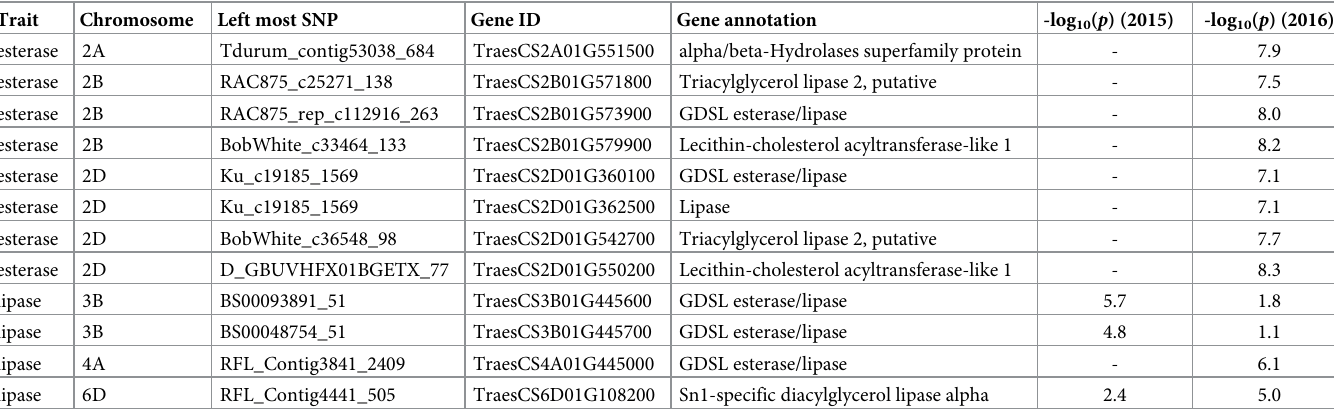
Table 2. Genes putatively involved in the genetic determination of esterase and lipase.